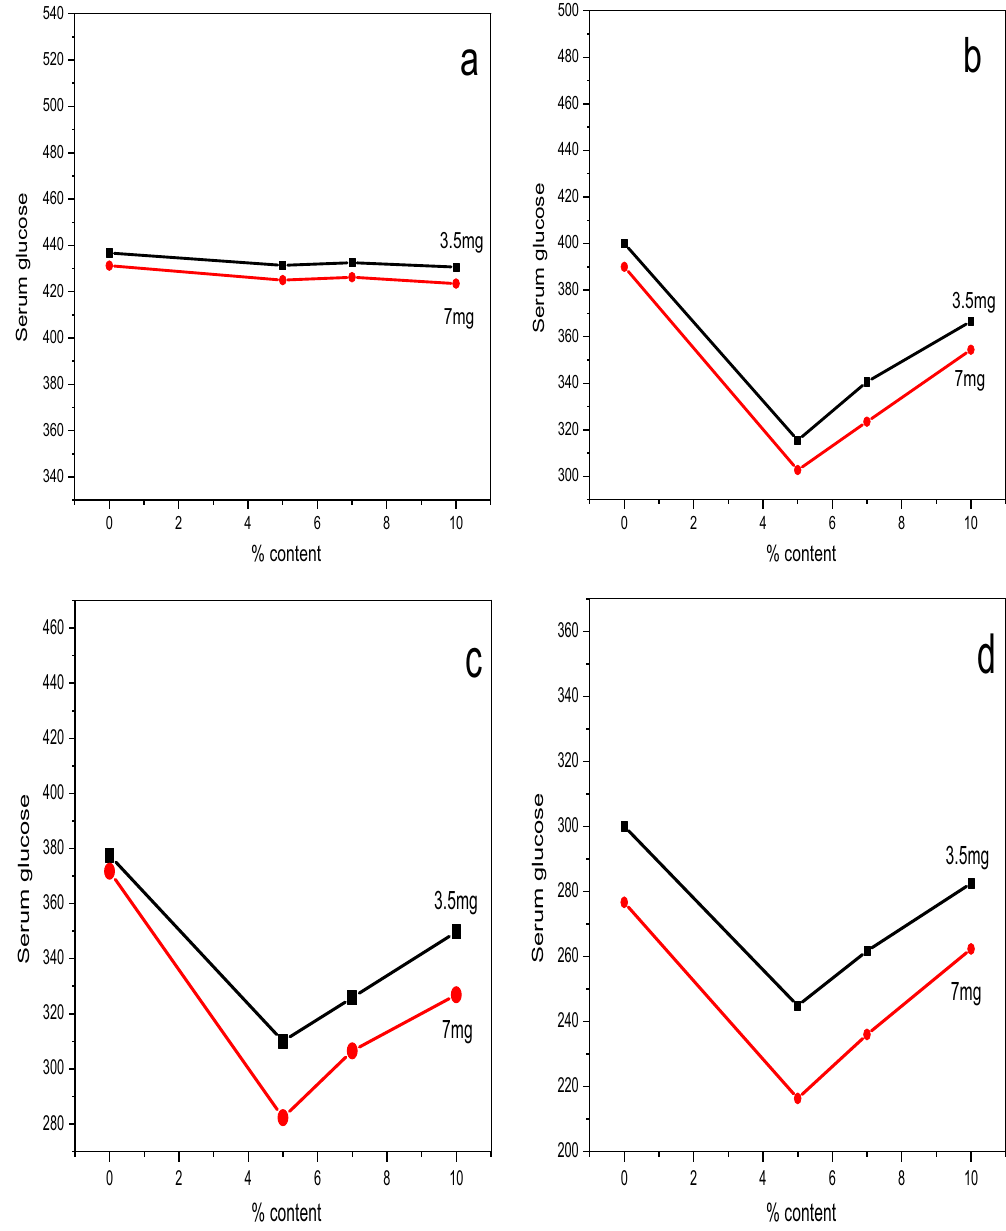
Figure 12. Glucose level against PVA content for ( a ) 0, ( b ) 5, ( c ) 10 and ( d ) 20 days calcined at 300 °C for two series 3.5 mg and 7